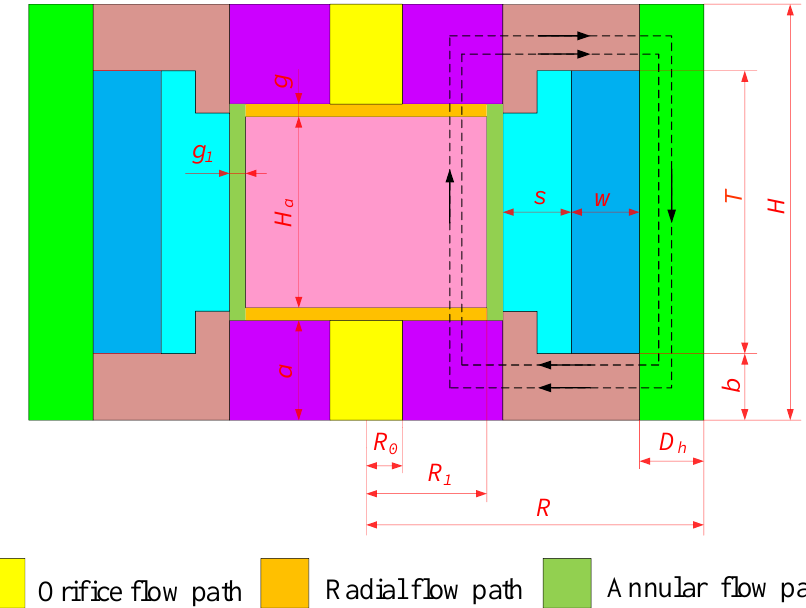
Figure 2. Magnetic circuit of radial MR valve.